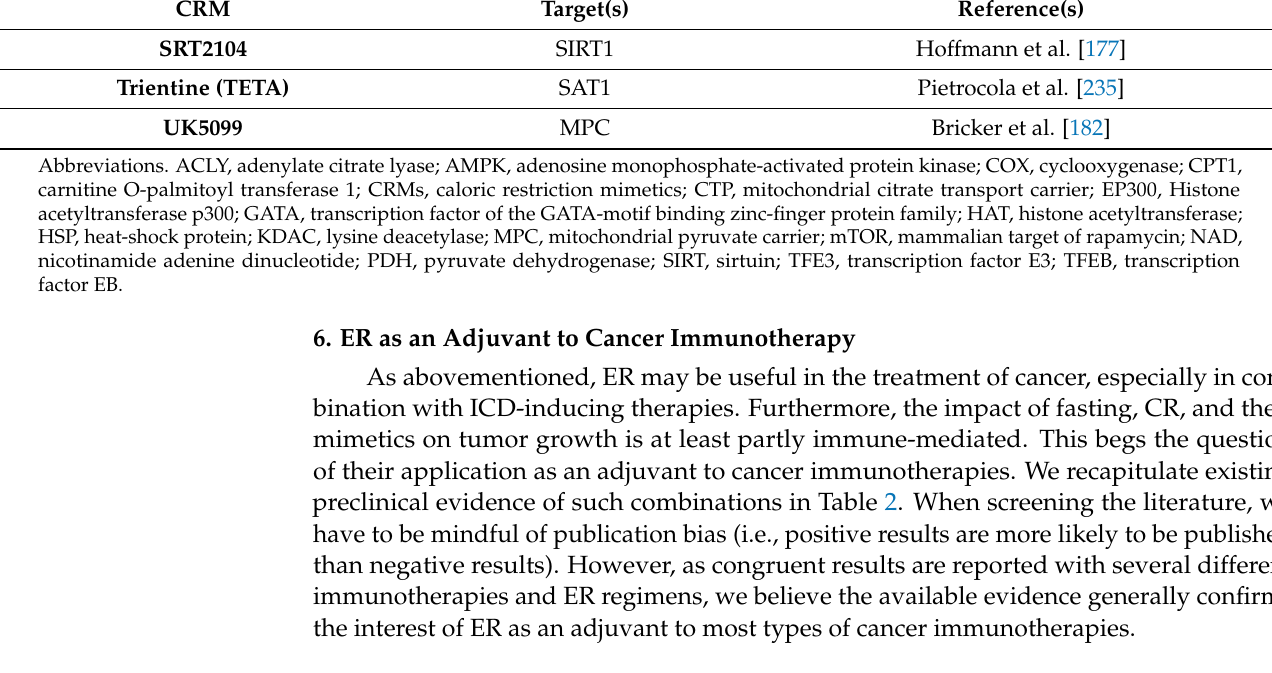
Table 2. Reported regimens associating ER to immunotherapies in preclinical